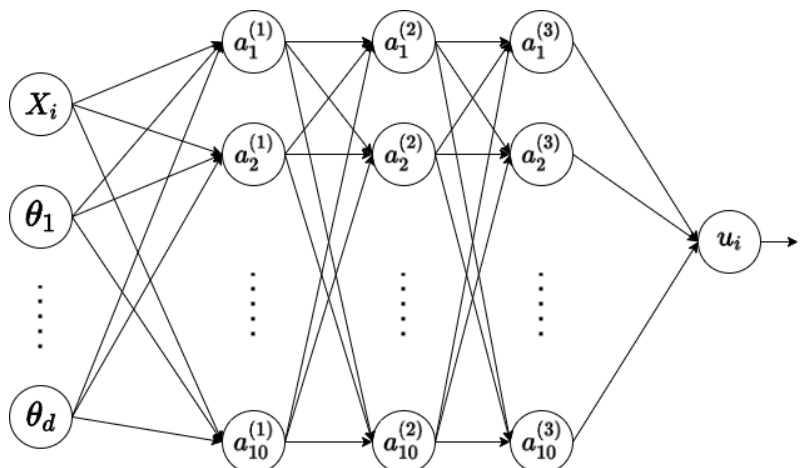
Figure 1. Three hidden layer neural network for computation of u i